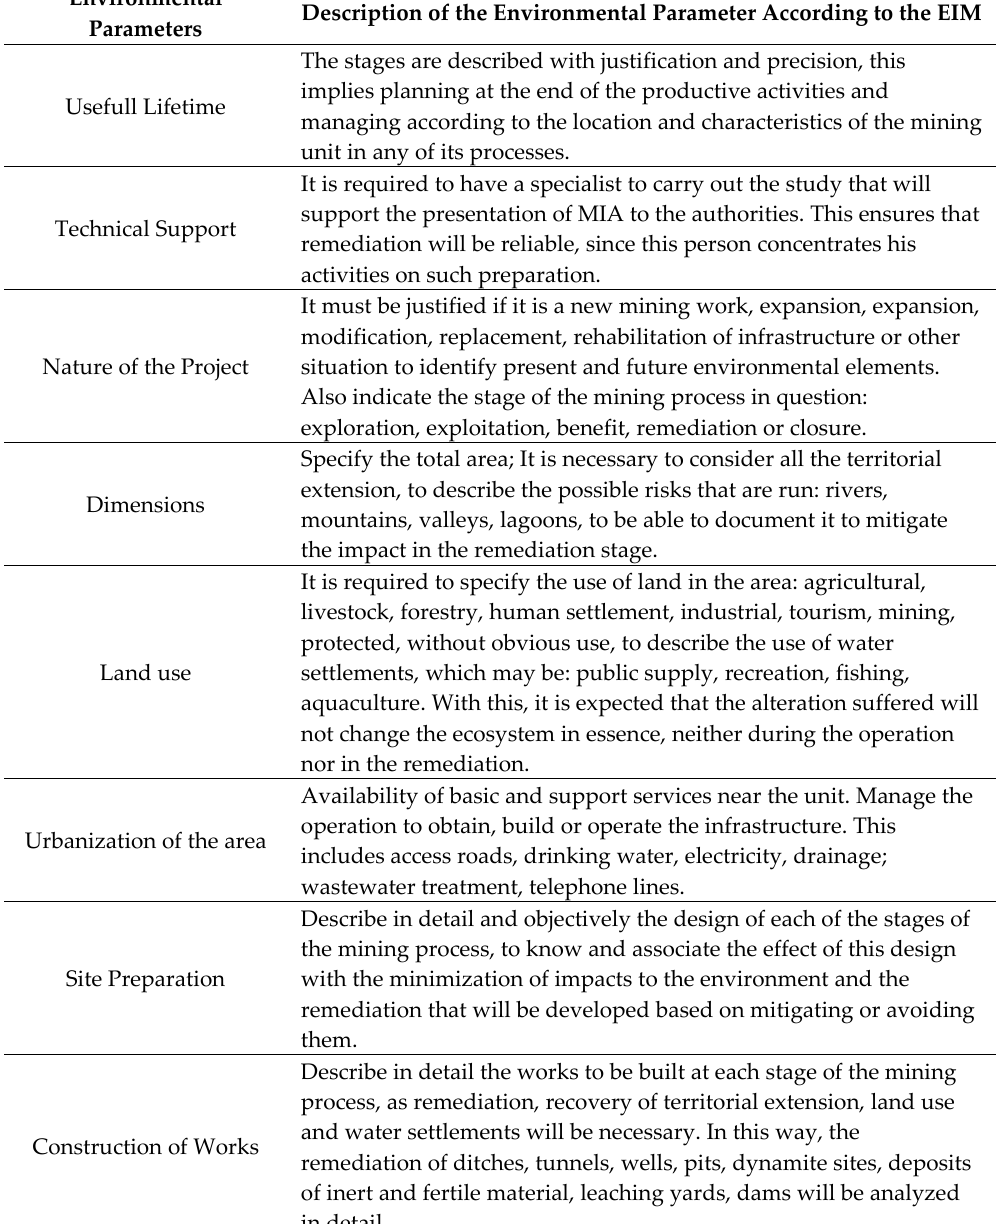
Table 2. Relationship of environmental parameters and their description; based on Environmental Impacts Manifest. Source: own